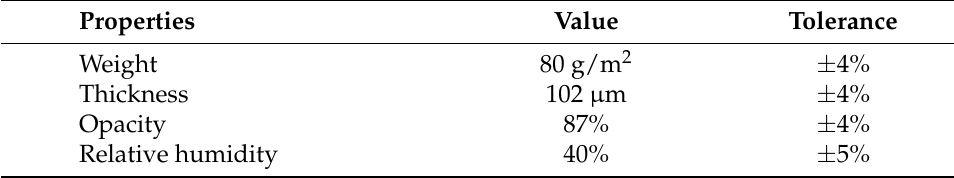
Table 1. The physical characteristics of the copy paper